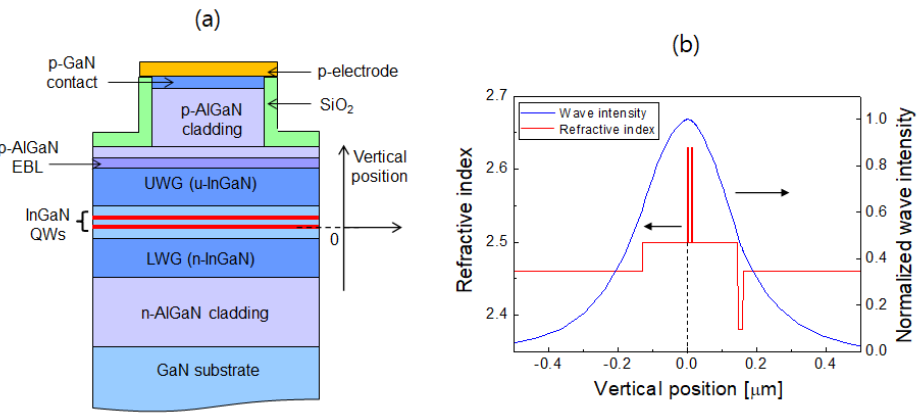
Figure 1. ( a ) Schematic of the simulated LD structure. ( b ) Vertical profiles of the refractive index (left vertical axis) and the normalized wave intensity of the lasing mode (right vertical axis) of the simulated LD structure. The origin of the vertical position corresponds to the bottom interface of the n-side QW, as indicated by the dotted lines in ( a ).